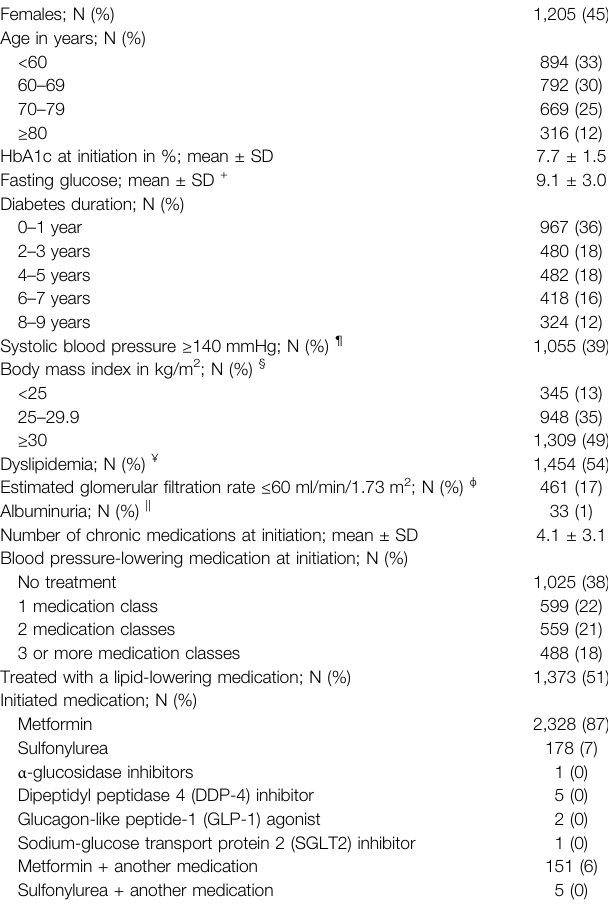
TABLE1| CharacteristicsofpatientsincludedintheglycosylatedhemoglobinA1c (HbA1c) threshold analyses ( N =